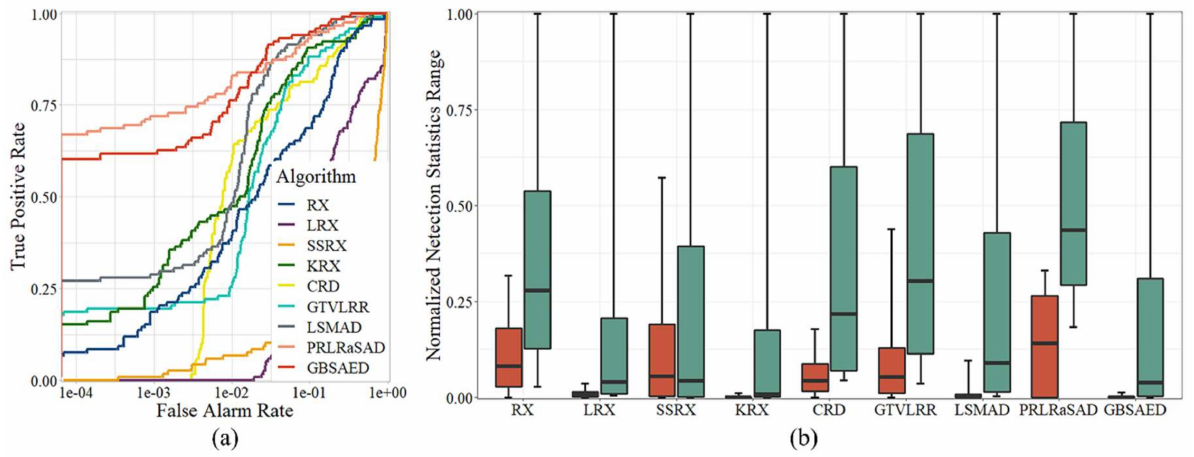
Figure 14. Quantitative analysis of the detection results of the various algorithms for the Xiong’an Image: ( a ) ROC curves and ( b ) target-background separation map.